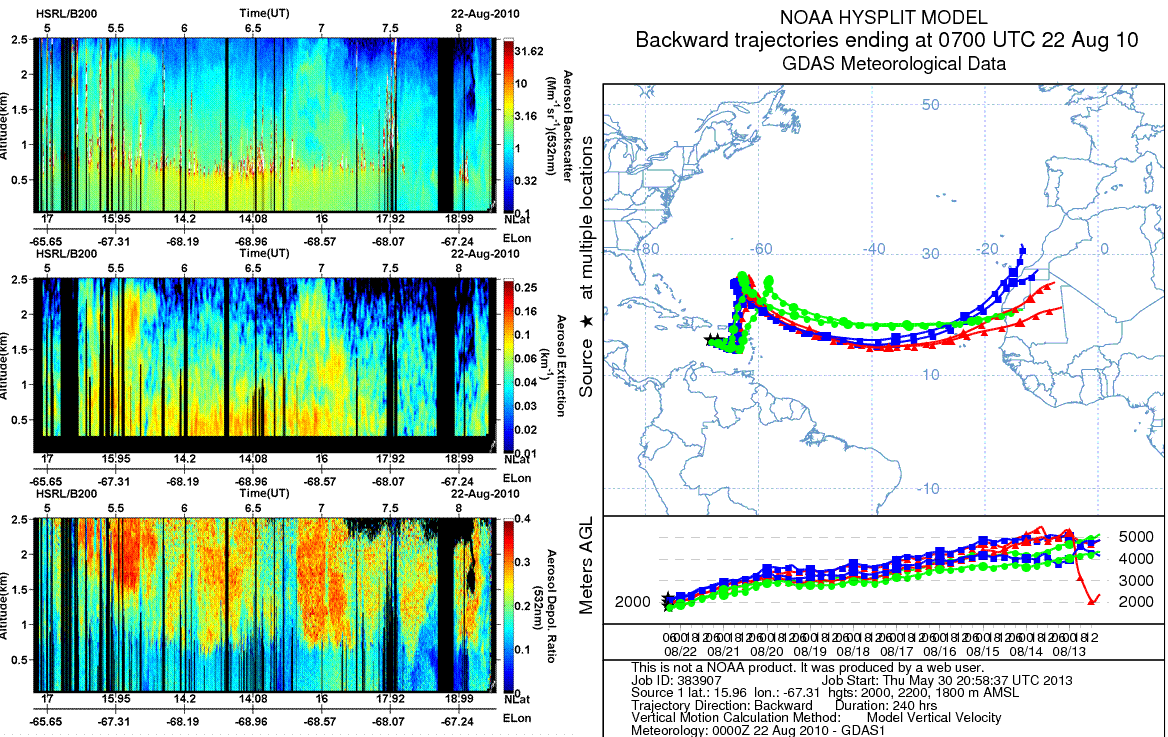
Fig. 6. HSRL-1 measurements (left three panels) of aerosol backscatter coefficient, aerosol extinction coefficient and aerosol depolarization ratio, δ , on 22 August 2010 in the Caribbean Sea. High values of depolarization indicate a layer of transported Saharan dust, which is mixing with the marine boundary layer. On the right is a set of NOAA HYSPLIT back-trajectories ending within the observed dust layer; the trajectories lead back to Saharan